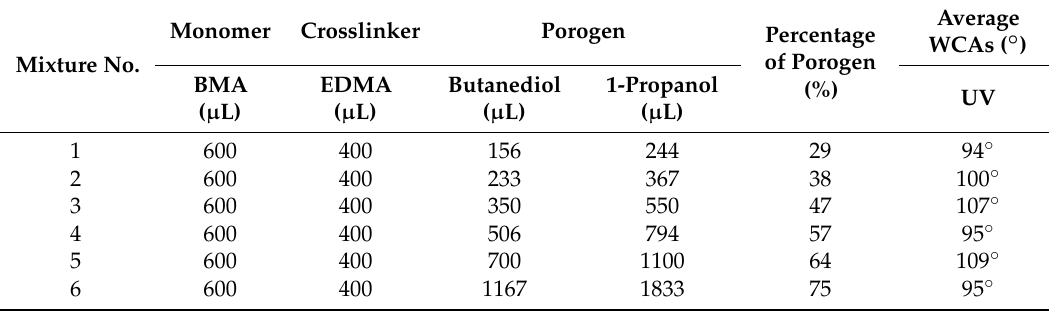
Table 1. Preparation conditions for the monolithic coatings of poly(BMA-co-EDMA) and their water contact angles (WCAs) using ultraviolet (UV) irradiation.